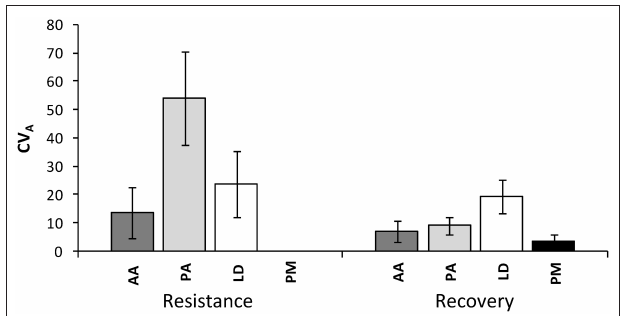
FIGURE 5 | Evolvability of drought response (resistance and recovery) within provenances given as an additive genetic coefficient of variation CV A across all provenances of each species. Whiskers mark the standard error of individual provenances. AA, Abies alba ; PA, Picea abies ; LD, Larix decidua ; PM, Pseudotsuga menziesii .